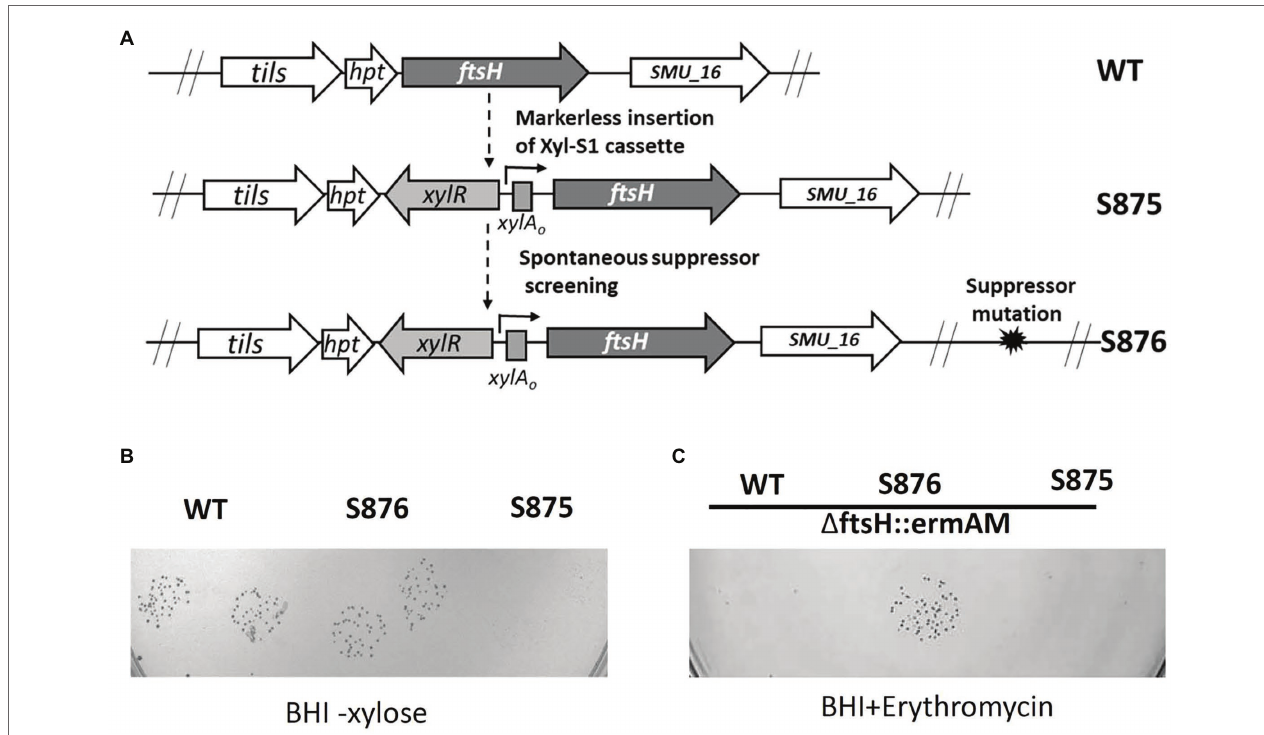
FIGURE 2 | ftsH suppressor mutant screening. (A) Illustration of the scheme to obtain the chromosomal inducible ftsH strain S875 and the suppressor mutant strain S876. (B) S. mutans UA159 (WT), the suppressor mutant strain (S876) and the inducible ftsH expression strain (S875) were all cultured in BHI containing 0.5% (w/v) xylose. Each overnight culture was washed, serially diluted to 10 −5 , spotted in duplicate onto BHI agar lacking xylose, and then incubated overnight at 37 ° C. (C) The ftsH deletion construct ∆ ftsH::ermAM was transformed into following strains: wild type strain UA159 (WT), ftsH suppressor mutant strain (S876), and inducible ftsH expression strain (S875). About 10 μ l of each transformation reaction without dilution was spotted onto BHI medium containing 12.5 μ g ml −1 erythromycin and incubated for 24 h at 37 ° C. This experiment was performed three times with similar